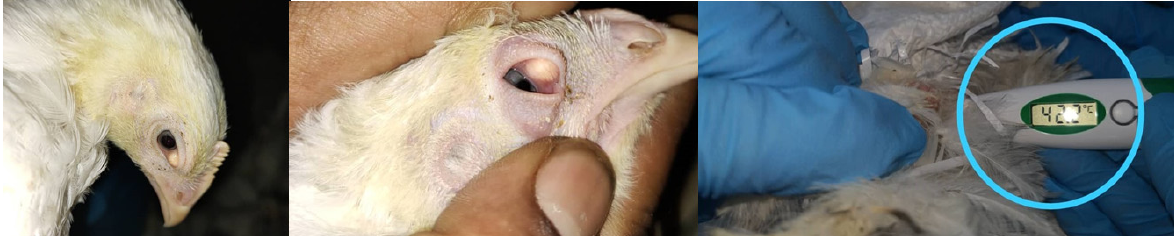
Figure 7. Sign of vaccine reactions or IBV postvaccine challenge in mildly infected eyes with slightly high temperature after 3 days post vaccination of IB Mass (day 21 and day 93) in field application.